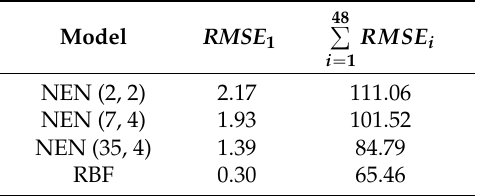
Figure 8. One-step-ahead error for the NEN algorithm ( Top ) and the RBF ANN ( Middle ); considering the last 1350 data points. Evolution of the RMSE ( Bottom ), along the prediction horizon instants, for air temperature forecasts obtained by the RBF model (black), and the NEN algorithm: Red (2, 2), blue (7, 4) and green (35, 4). Table 1. Root mean square errors (RMSEs) of Temperature.